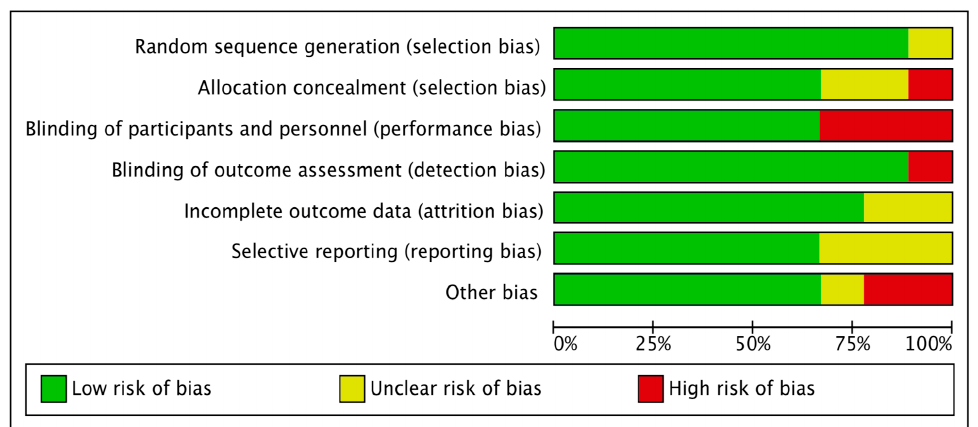
Figure 3. Overall risk of bias in included studies: review authors’ judgment (low, unclear, high) for risk-of-bias item shown as percentages across all included studies.